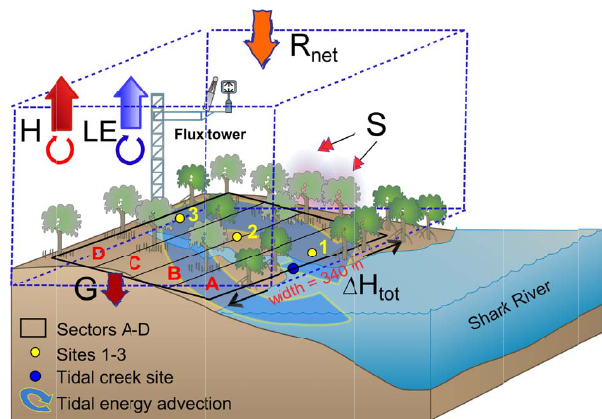
Fig. 2. Conceptual cross section of the study site with key compo- nents of the daytime surface energy budget. (When considering the full diel cycles, the fluxes are bidirectional.) Each of sectors A–D has a width (340m) perpendicular to the axis of the tidal creek. Inundation level, water temperature, and soil heat flux ( G ) were measured at sites 1–3. Recharge, water level and temperature were measured within the mouth of the tidal creek site. The H and LE represent the sensible and latent heat exchanges between the man- grove forest and the atmosphere. S is the sum of heat and biochem- ical energy storage in biomass. The 1H tot represents the sum of enthalpy change in the water column in the forest ( 1H stor ) and heat exchange of water advected ( 1H adv ) during recharge (discharge) entering (exiting) the tidal